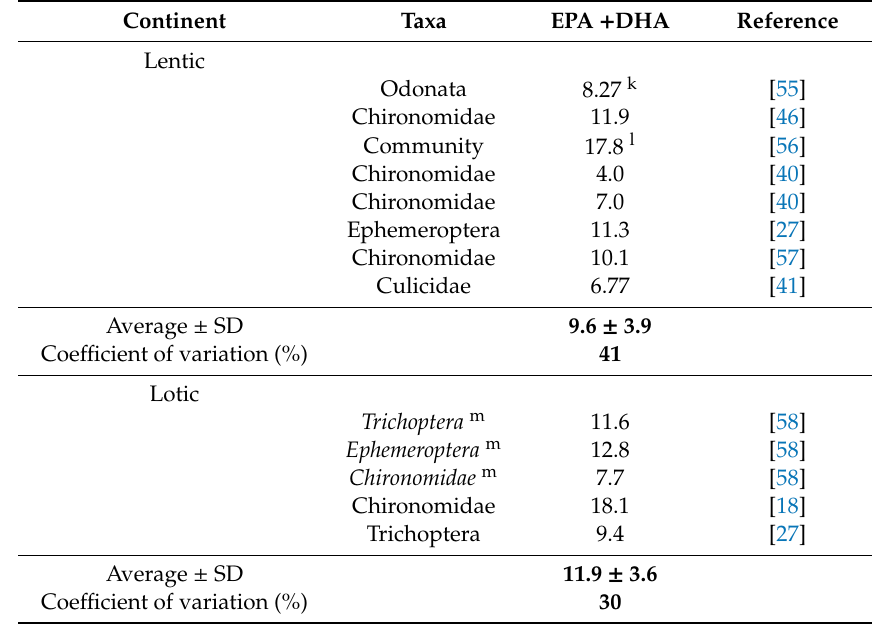
Table 3. Physiologically important fatty acids (EPA + DHA, mg g − 1 of dry mass) in emergent aquatic insects in lakes and rivers. Taxa in italics represent fatty acids measured in insect larvae. Average and coe ffi cient of variation in bold represents the grand average that was used to calculate emergence for all six continents.